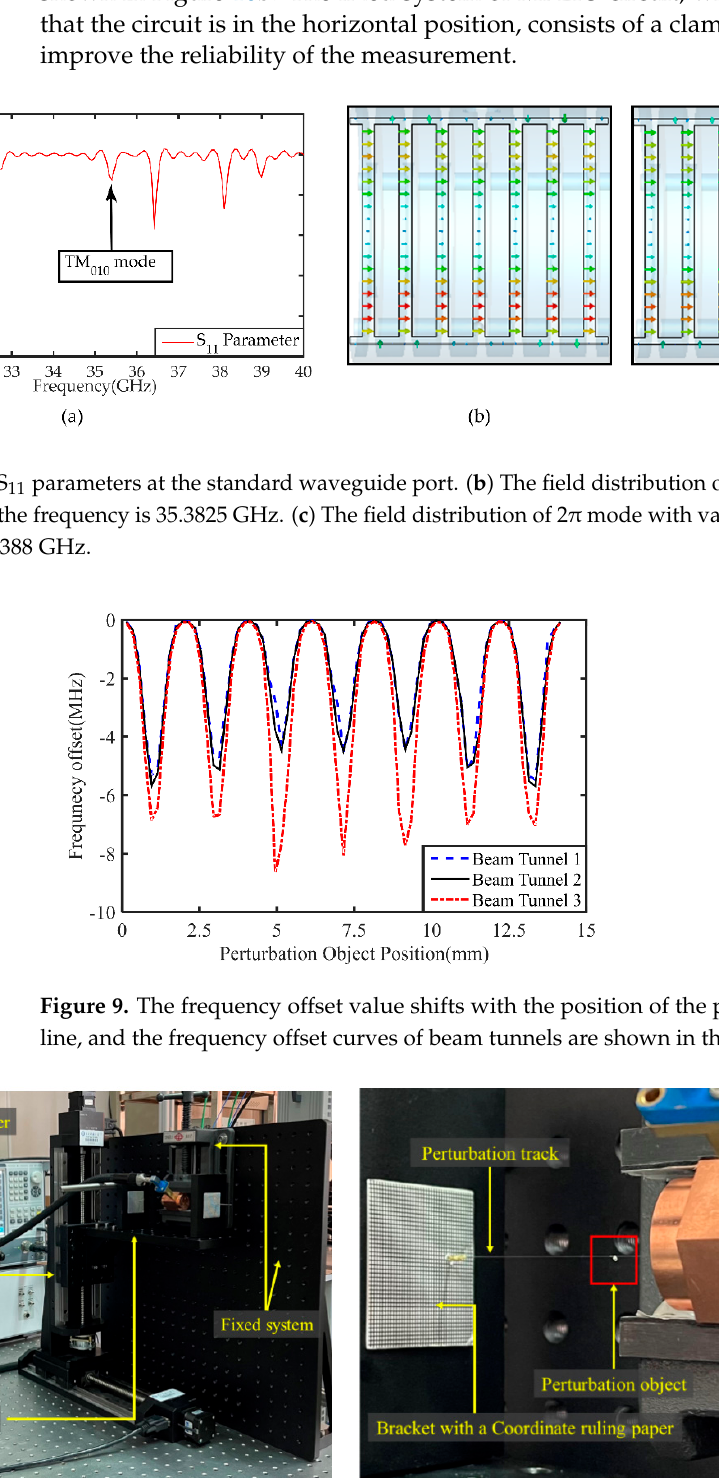
Figure 8. ( a ) Simulated S 11 parameters at the standard waveguide port. ( b ) The field distribution of 2 π mode with dielectric perturbation object and the frequency is 35.3825 GHz. ( c ) The field distribution of 2 π mode with vacuum perturbation object and the frequency is 35.388 GHz.